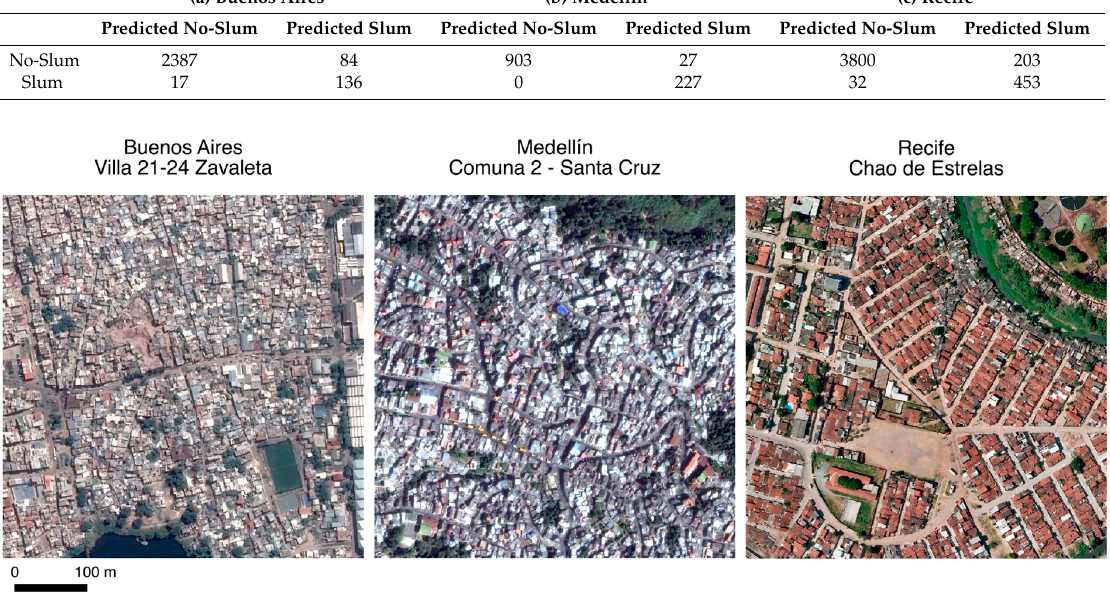
Figure 11. Sectors of known slum areas in each city. From left to right: Buenos Aires, Medellin and Recife. Table 9. General characteristics of slums in the analyzed cities.